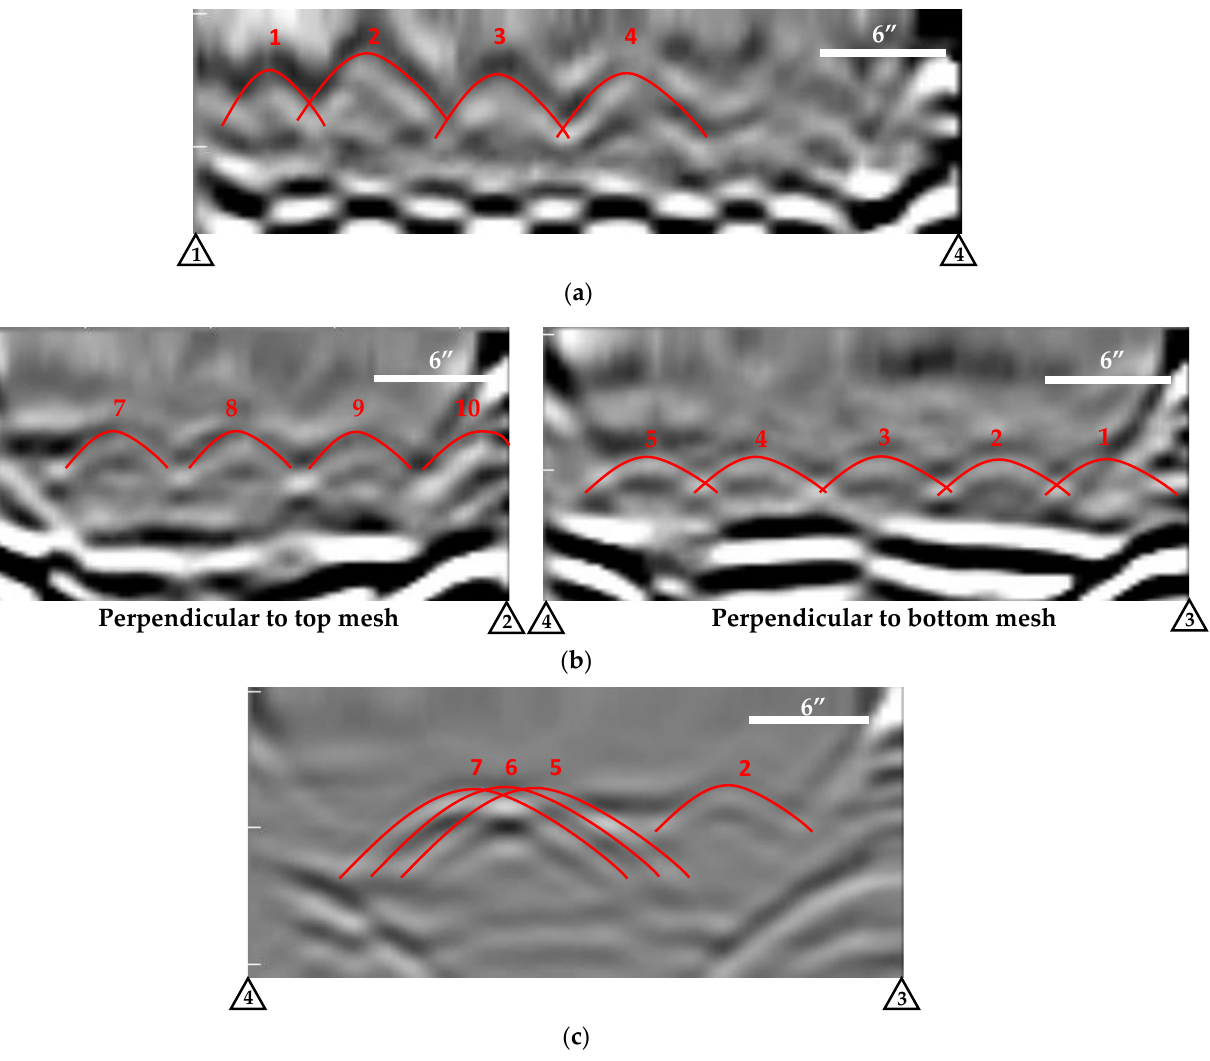
Figure 9. Line scan results of Conquest 100 Enhanced for different slab specimens: ( a ) Slab C, ( b ) Slab J, ( c ) Slab L. Table 5. Bar detectability in line scans performed using Conquest 100 Enhanced.